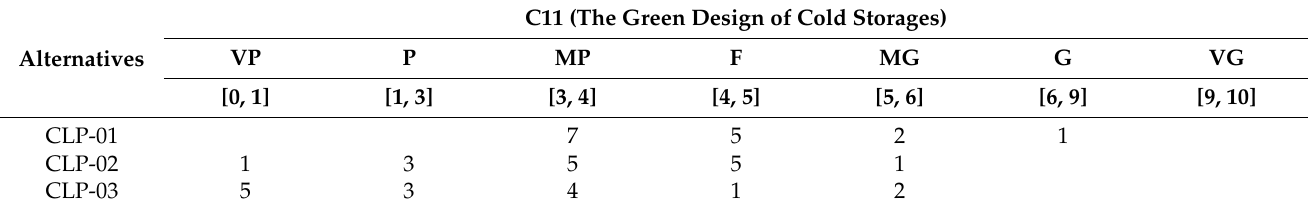
Table 10. The initial evaluation matrix of C1